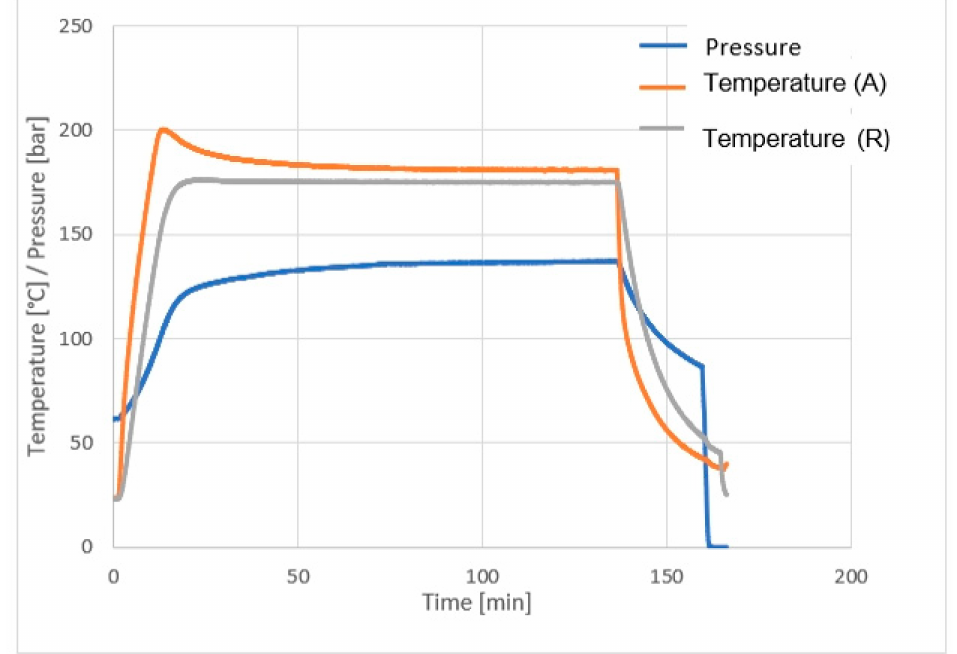
Figure 5. Pressure, temperature and time curves during work in autoclave (R-reaction;